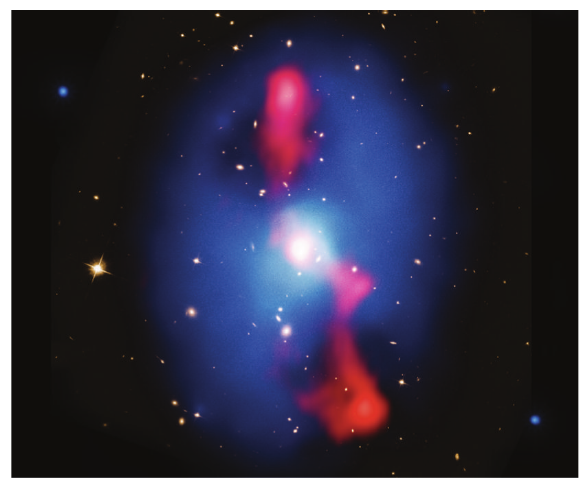
Figure 4: Deep ∼ 500 ks Chandra X-ray image (blue) and Very Large Array 330 MHz radio image (red) superposed with the Hubble Space Telescope visual image of the galaxy cluster MS 0735 + 7421. The giant X-ray cavities, filled with radio emission, are surrounded by a cocoon shock clearly visible in the Chandra image as an elliptical edge. The box is roughly 800 kpc by 800